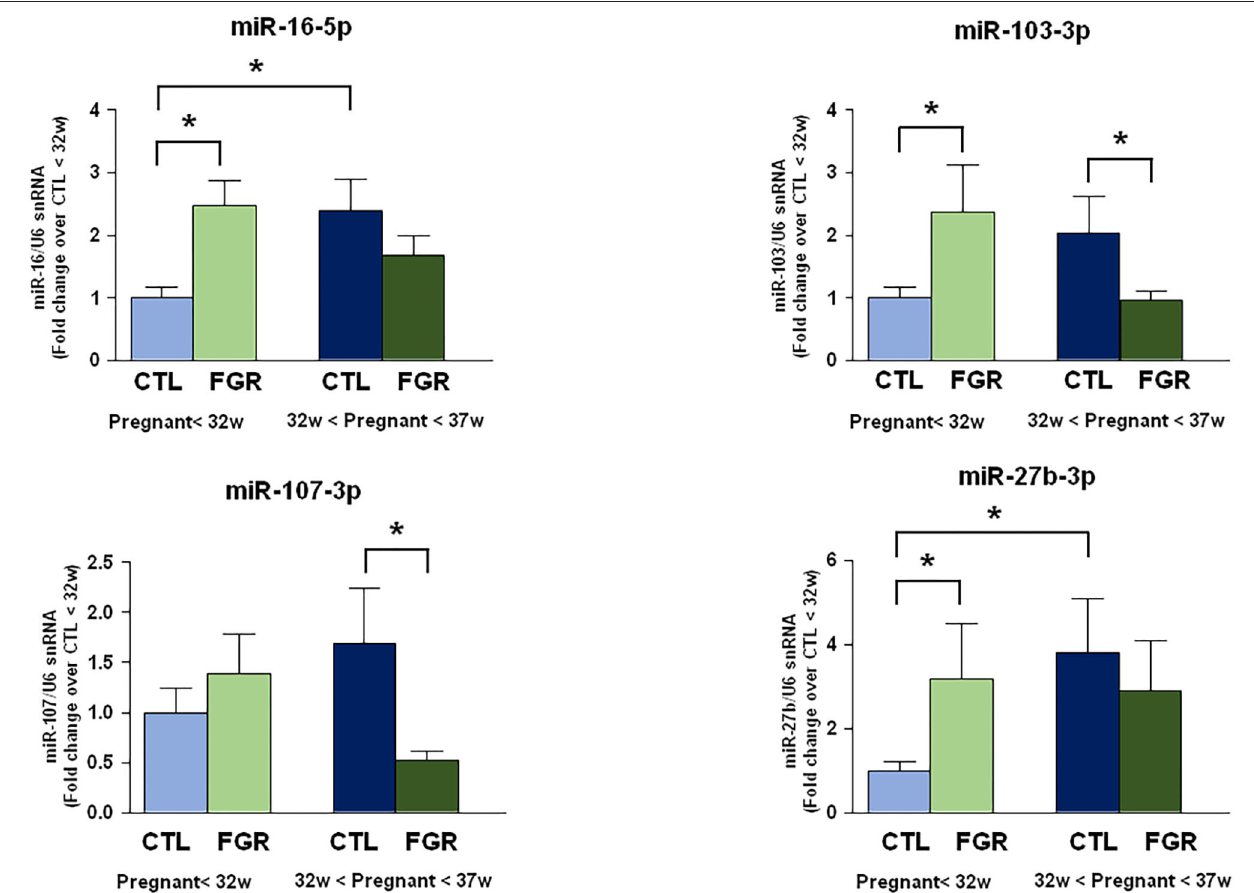
FIGURE 1 | Expression analysis by real-Time PCR of hypoxia induced miRNAs in maternal blood from women with preterm FGR compared to gestation matched controls. MicroRNA levels analyzed by real-Time PCR in plasma samples are expressed as fold change of relative expression levels over the healthy group < 32nd week of gestation setted at 1. Each column represents the mean ± S.E.M. Results of microRNAs expression were normalized with respect to U6 snRNA as internal control. * p <